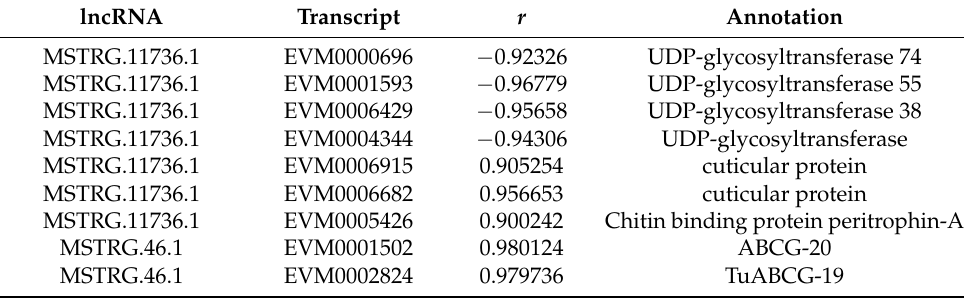
Figure 6. Functional prediction and identification of hub lncRNAs. ( A ) Co-expression networks of lncRNA and protein- coding genes constructed in the molting processes of different development stages by using Pearson’s correlation coefficient. ( B ) Heat map of seven hub lncRNAs in the molting process of different development stages. ( C ) KEGG pathways were enriched for each module in the co-expression network. Table 1. Correlations between known molting-related genes and